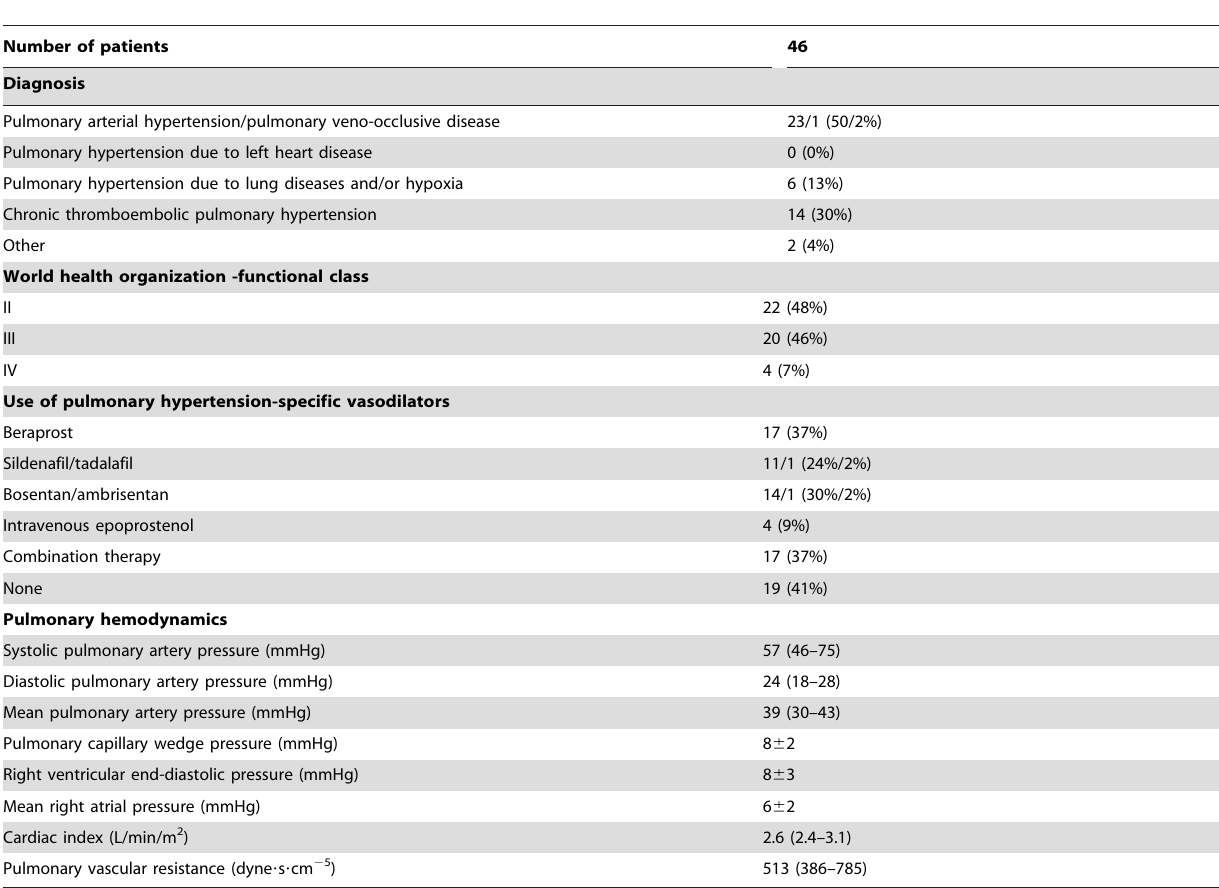
Table 1. Characteristics of patients with pulmonary